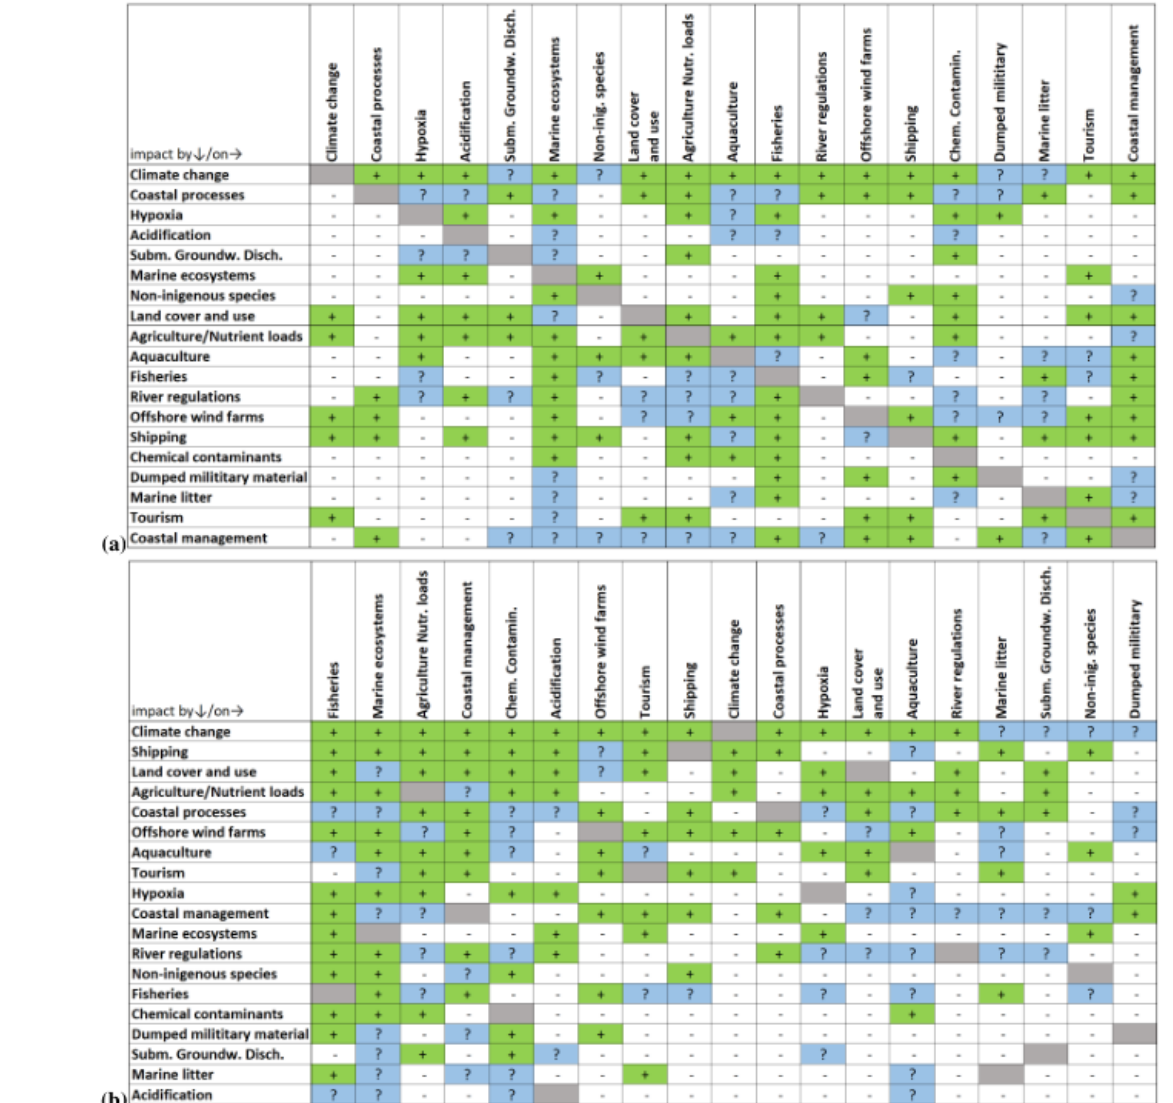
Table 2. (a) The matrix of factors. Natural (but affected by human activity) and entirely human factors are grouped together. Based on the current scientific literature, there is ( + , green) evidence for a connection, (?, blue) no direct evidence for a connection but a connection is plausible (based on authors’ judgement) and ( − ) no evidence for a connection (these combinations are not discussed in the text). The table is read (1) from left to right. For example, going to the right within the first line “Climate change” shows factors that climate change has an impact on (or not). (2) From top to bottom within a column, the table shows the factors that have an effect on, for example, climate change (using the first column). (b) As in (a) but sorted according to the number of positive connections ( +